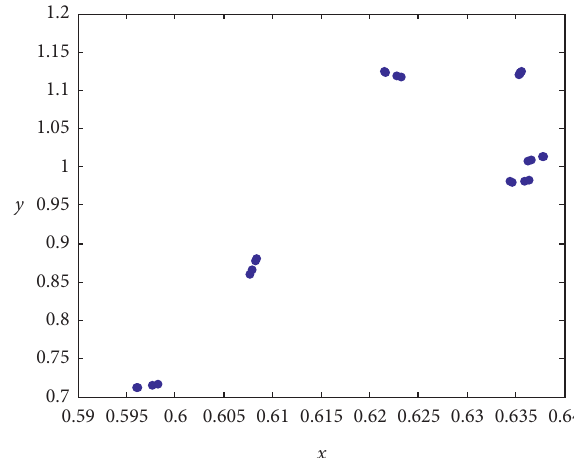
Figure 27: x - y phase diagram which denotes that the system is periodic when c �